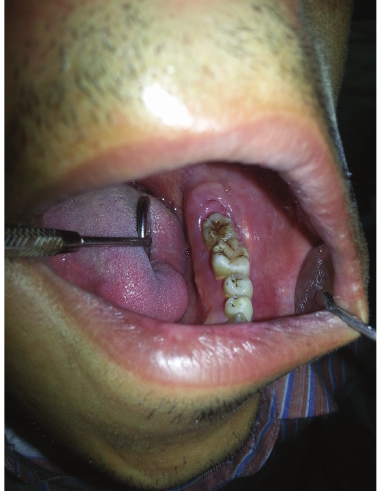
Figure 8: One month post operative view (mandibular).